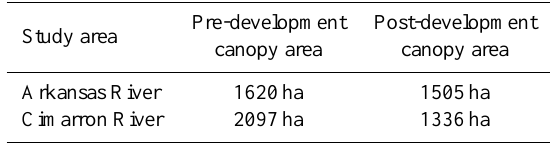
Table 2. Weighed mean and standard deviation for depth to water beneath